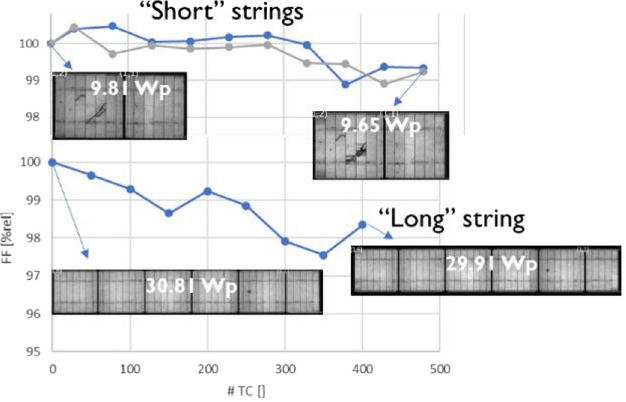
Fig. 4. Evolution of relative FF throughout thermal cycling for 2 short strings and 1 long string based on